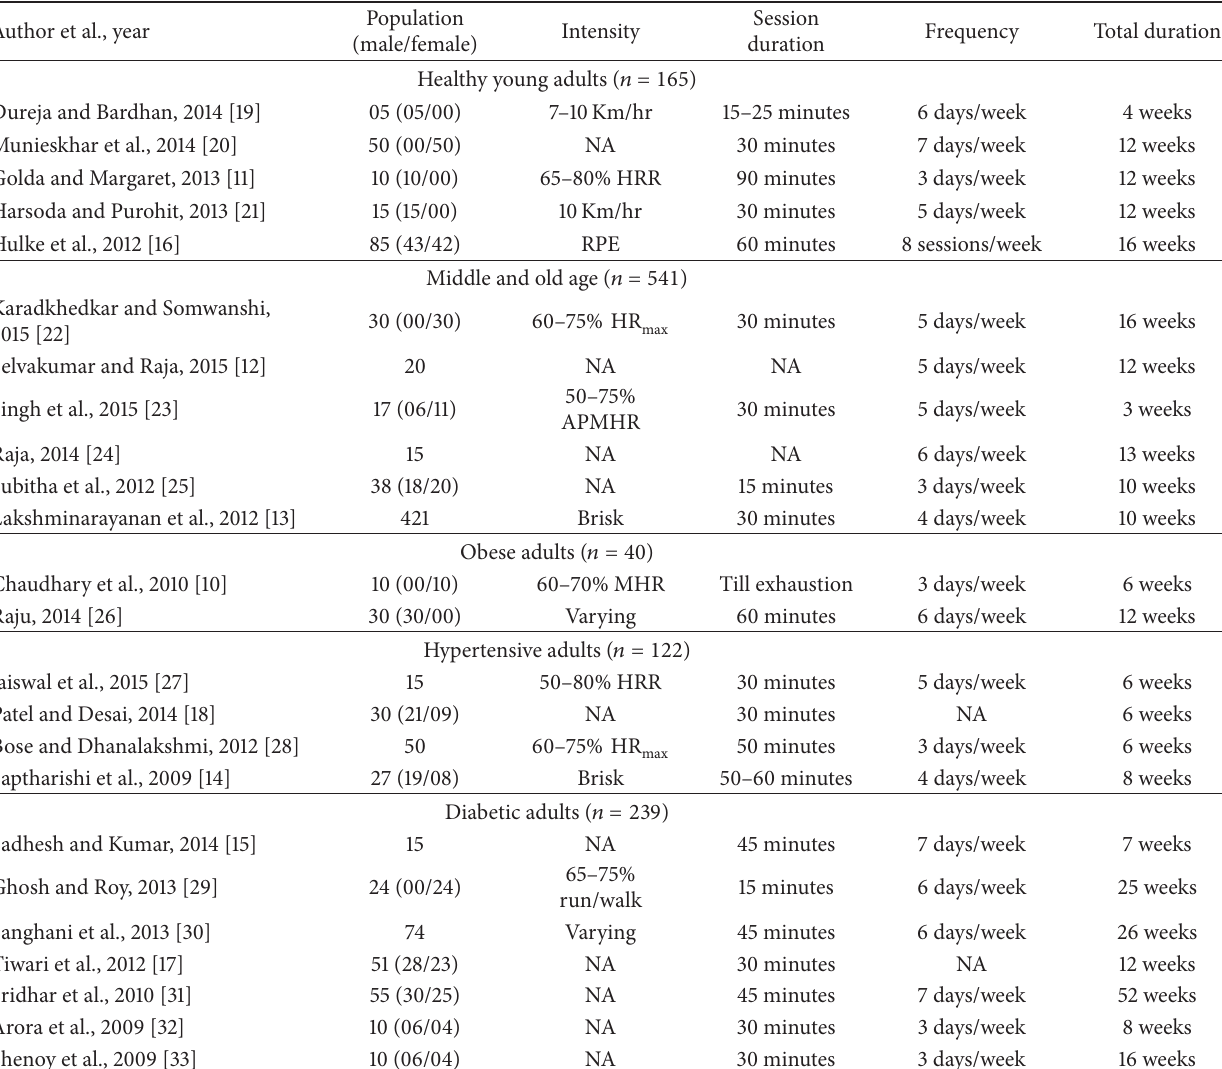
Table 1: Basic characteristics of included